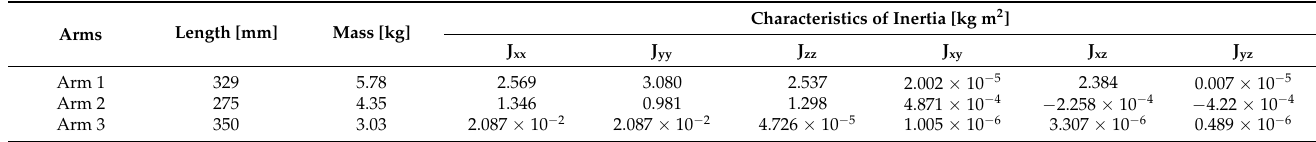
Table 2. Geometric dimensions and quality attributes of the robot arms.